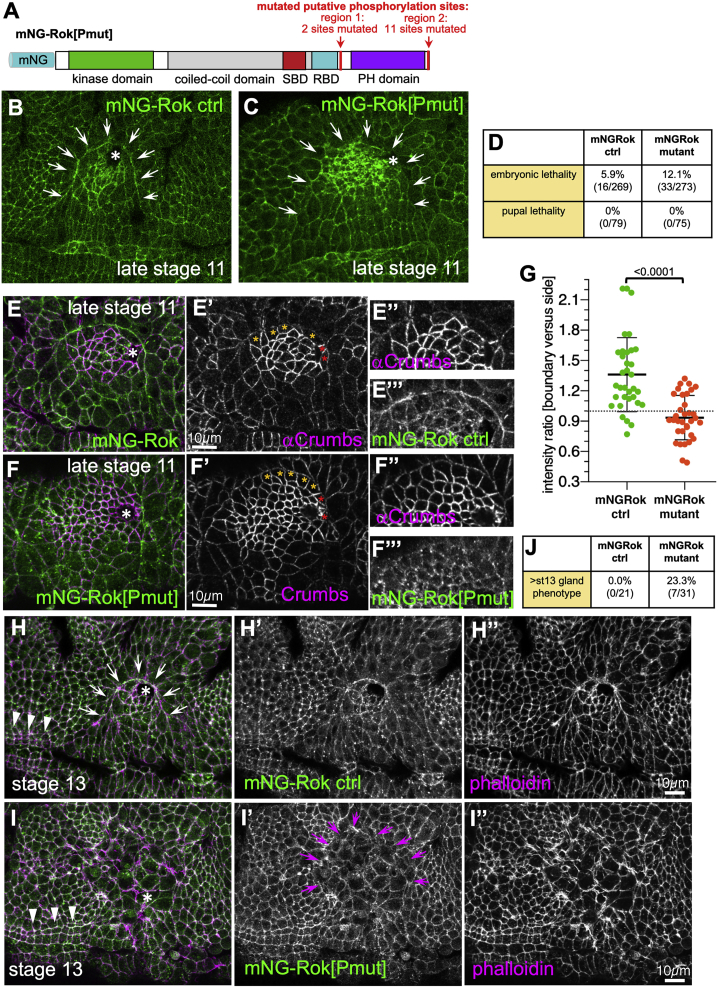
A Phospho-mutant Rok Shows Reduced Planar Polarization at the Boundary(A) Schematic of the potential target sites for aPKC or Pak1 phosphorylation that are mutated in the phospho-mutant Rok (mNG-Rok[Pmut]).(B and C) Localization comparison between mNG-Rok (B) and mNG-Rok[Pmut] (C). Arrows mark the boundary and the asterisks mark the invagination point.(D) Flies homozygous for mNG-Rok[Pmut] are semi-viable, with 12.1% of embryos not hatching compared with 5.9% in the mNG-Rok control.(E–G) Compared with the mNG-Rok control (E, green) that shows polarization at the boundary marked by Crumbs (magenta), mNG-Rok[Pmut] (F, green) shows a loss of polarization at the boundary marked by Crumbs (magenta). (G) Polarization quantification expressed as the intensity ratio of boundary junction versus side junction. Data are represented as data points, mean, and SEM. Mean values are as follows: mNG-Rok ctrl, 1.36 and mNG-Rok[Pmut], 0.935. Unpaired t test was used to compare samples, and p value is indicated.(H–J) Stage 13 mNG-Rok[Pmut] embryos show a strong disruption of the placodal boundary in 23.3% of embryos (compared with 0.0% in the control), Rok is in green in (H) and (I), with phalloidin to label cell outlines in magenta in (H) and (I).(J) Quantification of stage 13 gland phenotype prevalence. Arrowheads in (H) and (I) point to the pharyngeal ridges and identify embryos as stage 13, arrows in (H) point to the planar polarized mNG-Rok control at the boundary, and magenta arrows in (I’) point to the disorganized and disrupted boundary in mNG-Rok[Pmut].